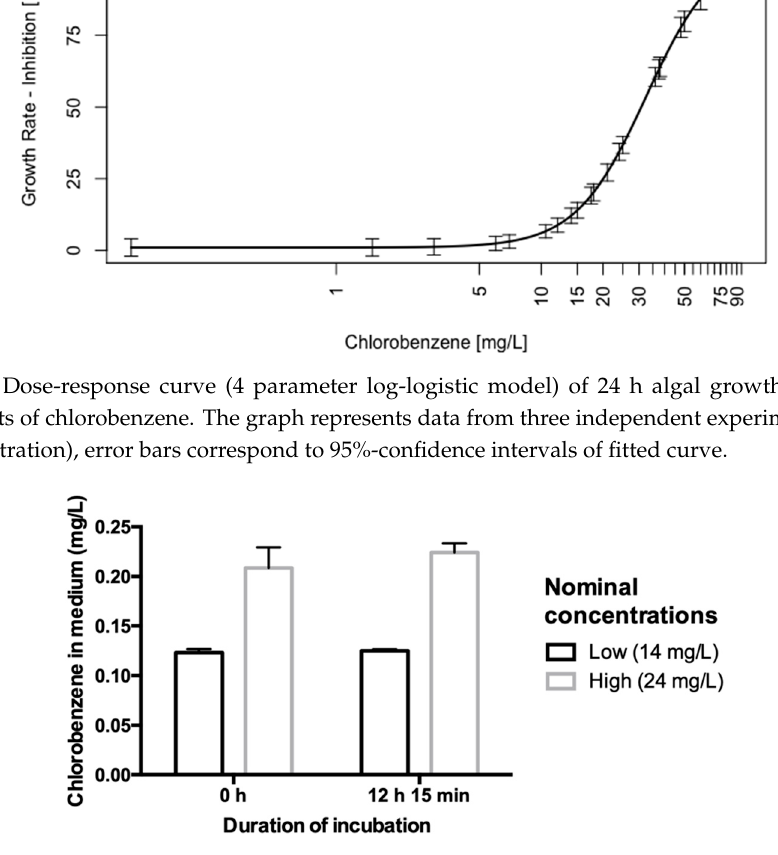
Figure 4. Dose-response curve (4 parameter log-logistic model) of 24 h algal growth inhibition experiments of chlorobenzene. The graph represents data from three independent experiments (n = 4 per concentration), error bars correspond to 95%- confidence intervals of fitted curve.